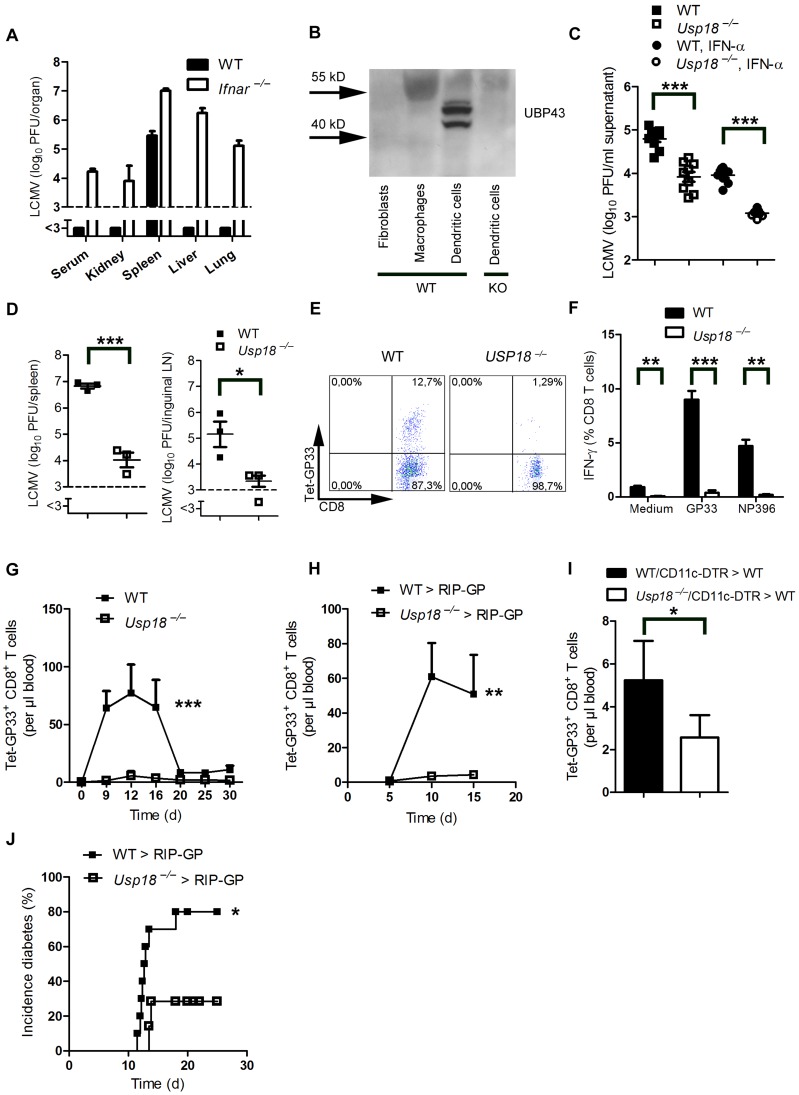
Expression of Usp18 in dendritic cells guarantees early viral replication and onset of autoimmune diabetes.(A) WT and Ifnar−/− mice were infected with 200 PFU of LCMV-WE. Viral titers were analyzed in various organs by plaque assay on day 4 (n = 4). (B) Expression of UBP43 (protein encoded by Usp18) was assessed by Western blot in bone marrow–derived dendritic cells, macrophages, and fibroblasts (n = 3). Dendritic cells from Usp18−/− mice served as a control for antibody specificity. (C) Bone marrow–derived dendritic cells from WT or Usp18−/− mice were infected with LCMV in vitro (MOI = 1) or left uninfected. In addition, cells were treated with recombinant IFN-α (50 U/mL) or left untreated. After 48 hours, LCMV titers were measured in the culture supernatants by plaque assay (n = 9). (D) WT and Usp18−/− mice were infected with LCMV 2×106 PFU. After one day viral titers were measured in the spleen and lymph nodes by plaque assay (n = 3). (E) FACS analysis of GP33+ CD8+ T cells measured in splenocytes from WT or Usp18−/− mice on day 7 after infection with 200 PFU LCMV-WE (One of three is shown). (F) FACS analysis of IFN-γ+ GP33+/and NP396+ CD8+ T cells measured in splenocytes from WT or Usp18−/− mice on day 7 after infection with 200 PFU LCMV-WE six hours after restimulation with GP33-peptide (n = 3–4). (G) FACS analysis of GP33+ CD8+ T cells measured in blood from WT or Usp18−/− mice at different time points after infection with 200 PFU LCMV-WE (n = 4–6, G). (H) RIP-GP mice were lethally irradiated and one day later were reconstituted with 107 bone marrow from either Usp18−/− mice or WT littermate control mice. Thirty days later, mice were infected with 200 PFU LCMV. GP33-specific CD8+ T cells in the blood were counted by flow cytometry at the indicated time points after LCMV infection (n = 4). (I) C57BL/6 mice were lethally irradiated and one day later were reconstituted with a 1∶1 mixture of bone marrow derived from Usp18−/− and CD11c-DTR mice or from WT and CD11c-DTR mice as control animals. Thirty days later, mice were treated intraperitoneally with diphtheria toxin (10 µg/kg) on days −1, 2, 5, and 8 and were infected intravenously with 2×106 PFU LCMV-WE on day 0 (n = 4). GP33-specific CD8+ T cells were assessed in peripheral blood 8 days after LCMV infection by tetramer staining and flow cytometric analysis. Results of 2 experiments are pooled. (J) RIP-GP mice were lethally irradiated and one day later were reconstituted with 107 bone marrow cells from either Usp18−/− mice or WT littermate control mice and were infected with 200 PFU of LCMV 30 days later. The incidence of autoimmune diabetes was determined by measuring serum glucose concentrations at the indicated time points (n = 7–10). * P<0.05, ** P<0.01 and *** P<0.001 (Student's t-test) (C, D, F and I), two-way analysis of variance (ANOVA) (G and H) or Log-rank (Mantel-Cox) (J).